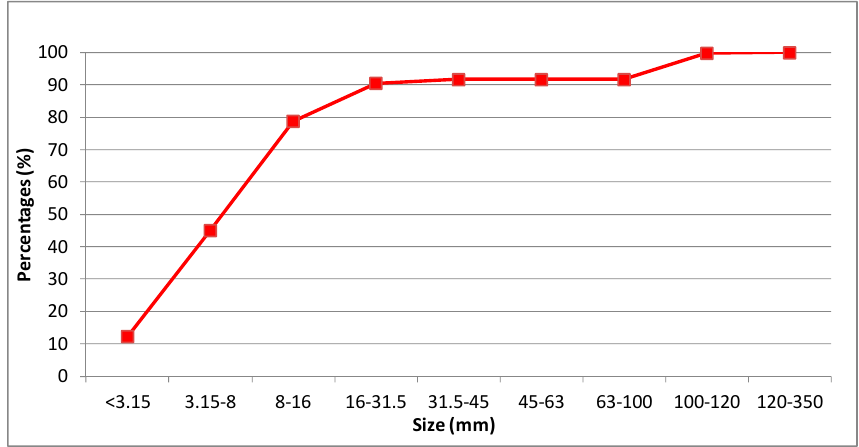
Figure 4. Cumulative distribution curves of the hog fuel produced by the Caravaggi mod. BIO900.